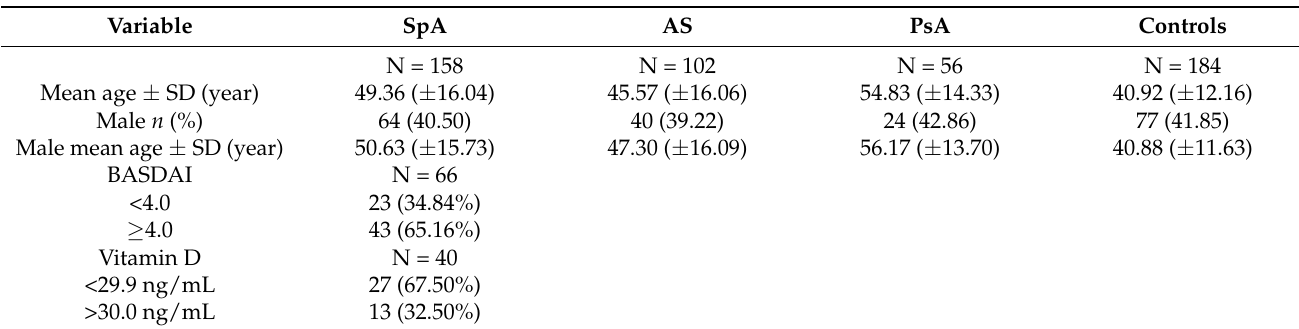
Table 1. Characteristics of HLA-B*27 negative patients with spondyloarthritis (SpA), ankylosing spondylitis (AS), and psoriatic arthritis (PsA) and HLA-B*27 negative controls.